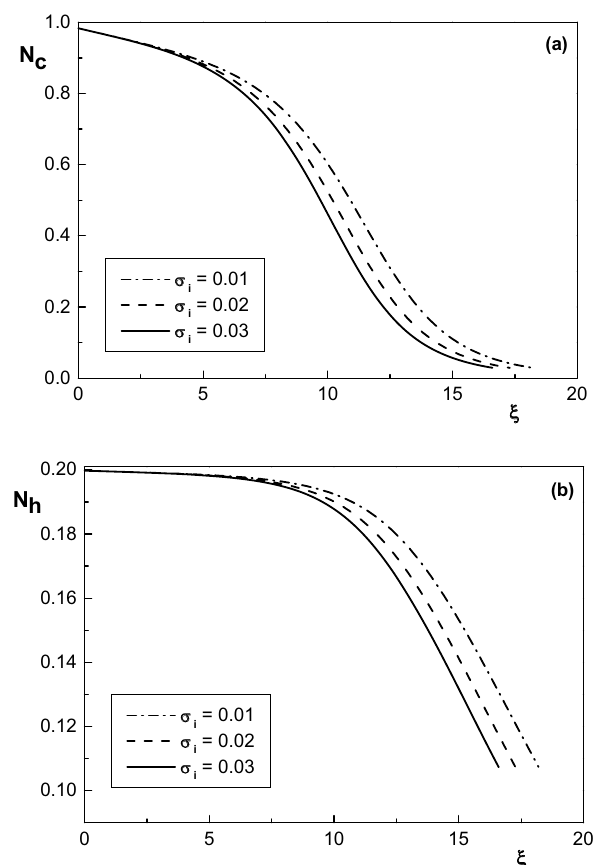
Figure 8. Spatial distribution of the normalized density of ( a ) cool and ( b ) hot electron species for κ c = 2.4 , δ b = 0.005 and different values of σ i . The other parameters are the same with Fig.